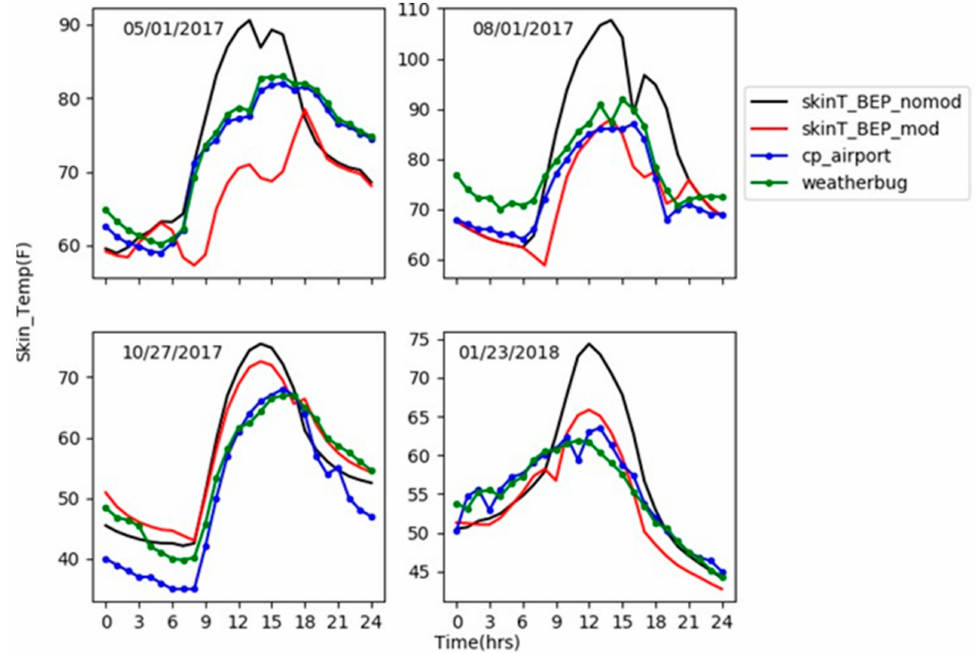
Figure 4. Comparison of two-meter air temperatures simulated by the original BEP (“BEP_nomod”) and improved BEP (“BEP_mod”) for the College Park airport and campus building WeatherBug sites for four di ff erent days in College Park,